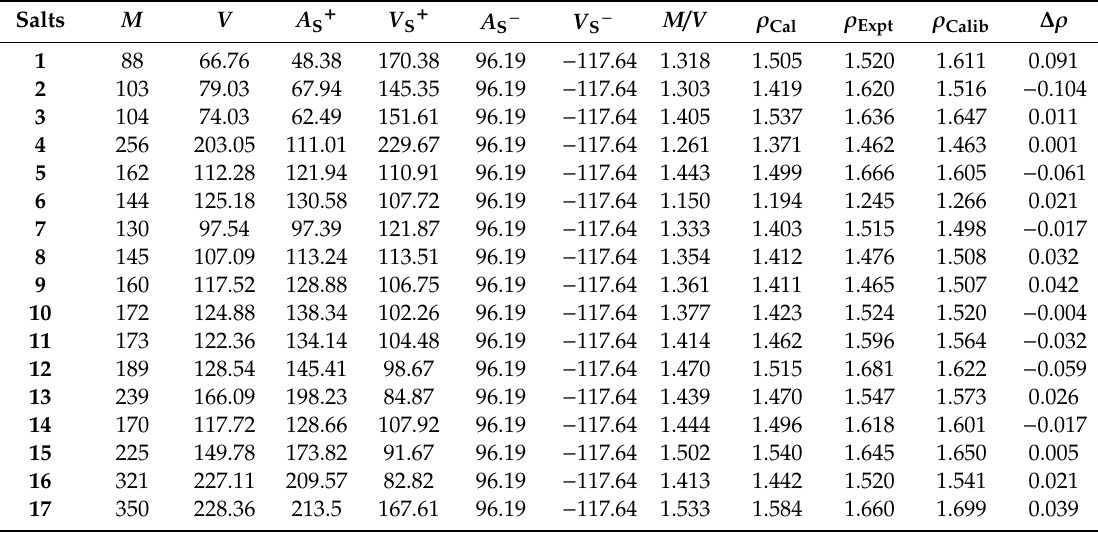
Table 1. Volumes (cm 3 / mol) and densities (g / cm 3 ) of the salts with cyclo -N 5 −